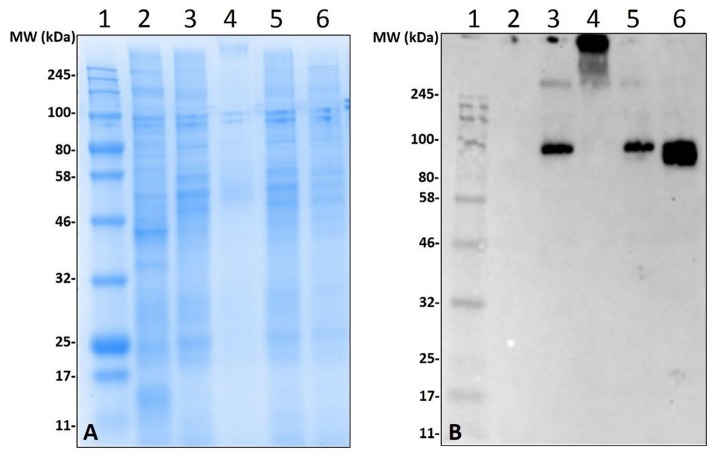
Deglycosylation of α-gal from sheep fed salivary glands and detection of α-gal in Am. americanum salivary glands that were fed using an in-vitro artificial membrane feeding system. SDS-PAGE (A) and α-gal immunoblot (B). Lane 1, a broad range molecular weight ladder; Lane 2, unfed Am. americanum SG. Lane 3, 7D partially-fed (on sheep) Am. americanum SG. Lane 4, deglycosylated partially-fed (on sheep) Am. americanum SG. Lane 5, 7D partially-fed (on sheep) Am. americanum SG. Lane 6, Am. americanum 7D partially-fed (artificially with membrane feeding system utilizing defibrinated human blood) salivary glands.